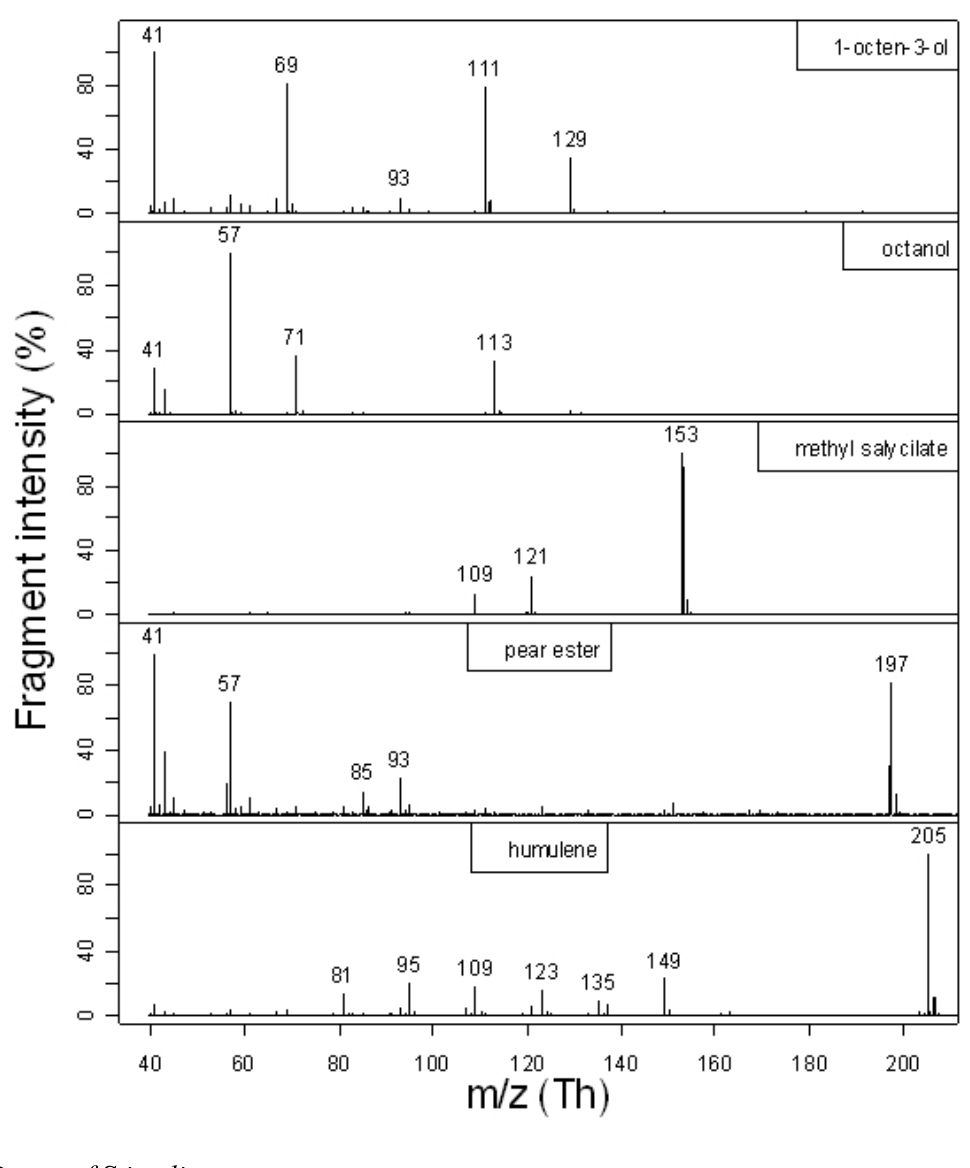
Figure 1. Fragmentation induced by proton transfer to the 5 compounds studied under the experimental conditions used in this work. Intensity is indicated as percentage of base peak (the tallest